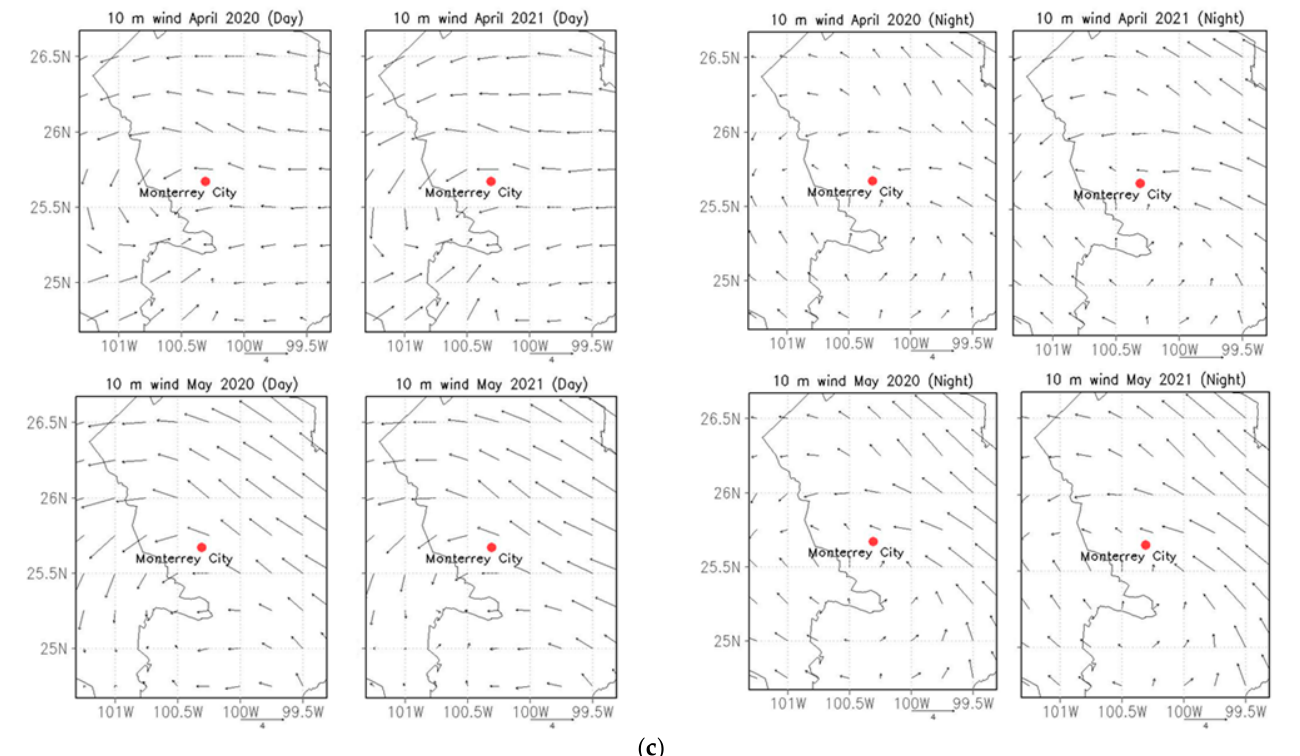
Figure A2. ( a ) Surface wind maps in Mexico City (red point) at daytime and nighttime. ( b ) Surface wind maps in Guadalajara (red point) at daytime and nighttime. ( c ) Surface wind maps in Monterrey (red point) at daytime and nighttime. Meteograms from Mexico City, Monterrey, and Guadalajara of stations with a significant relation (quantile regression) between wind speed and PM are shown in Figures A3–A5. In all cases, the blue line represents PM 10 concentrations, and the red line represents PM 2.5 concentrations.